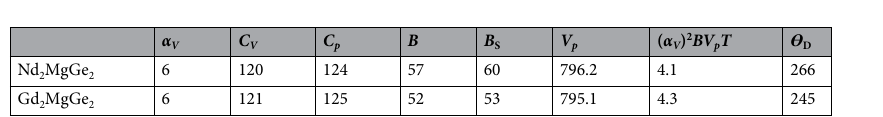
Table 5. Properties at 300 K: thermal expansion coefficient ( α V in 10 −5 K −1 ), vibrational contributions to the heat capacity at constant volume and pressure ( C V and C p in J/(mol K)), isothermal and adiabatic bulk moduli ( B and